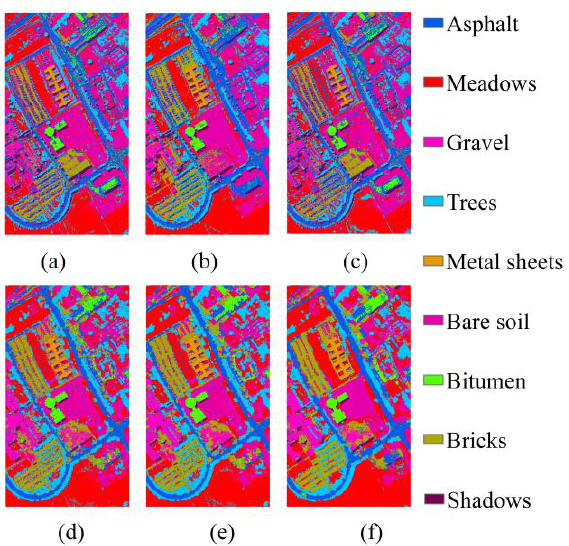
Figure 4. Classification maps of the University of Pavia: ( a ) SVM; ( b ) EMP; ( c ) SRC; ( d ) JSM; ( e ) AJSM; and ( f ) MLSR.